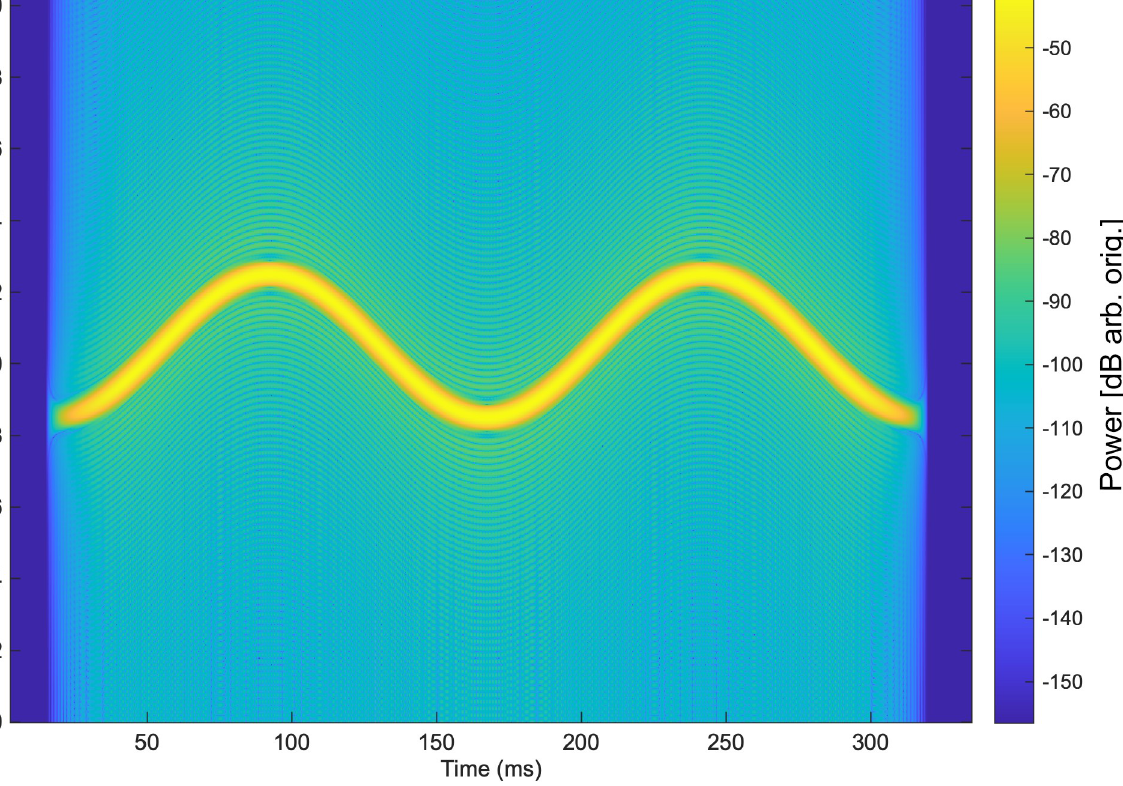
Fig 3. Spectrogram of an artificial whistle. Displayed is a standard, 1024-bin, Hamming-window spectrogram of one of the 128 tonals that was played (and here sampled) at 192 kHz; frequency resolution of the plot is 187.5 Hz (smoothing added). Note that the spectrogram was constructed from the unplayed, computational source signal (power level is arbitray). Duration = 0.3 s, Number of Cycles = 2, Center Frequency = 10500 Hertz, Cycle Amplitude = 2000 Hertz, Phase Start = - π